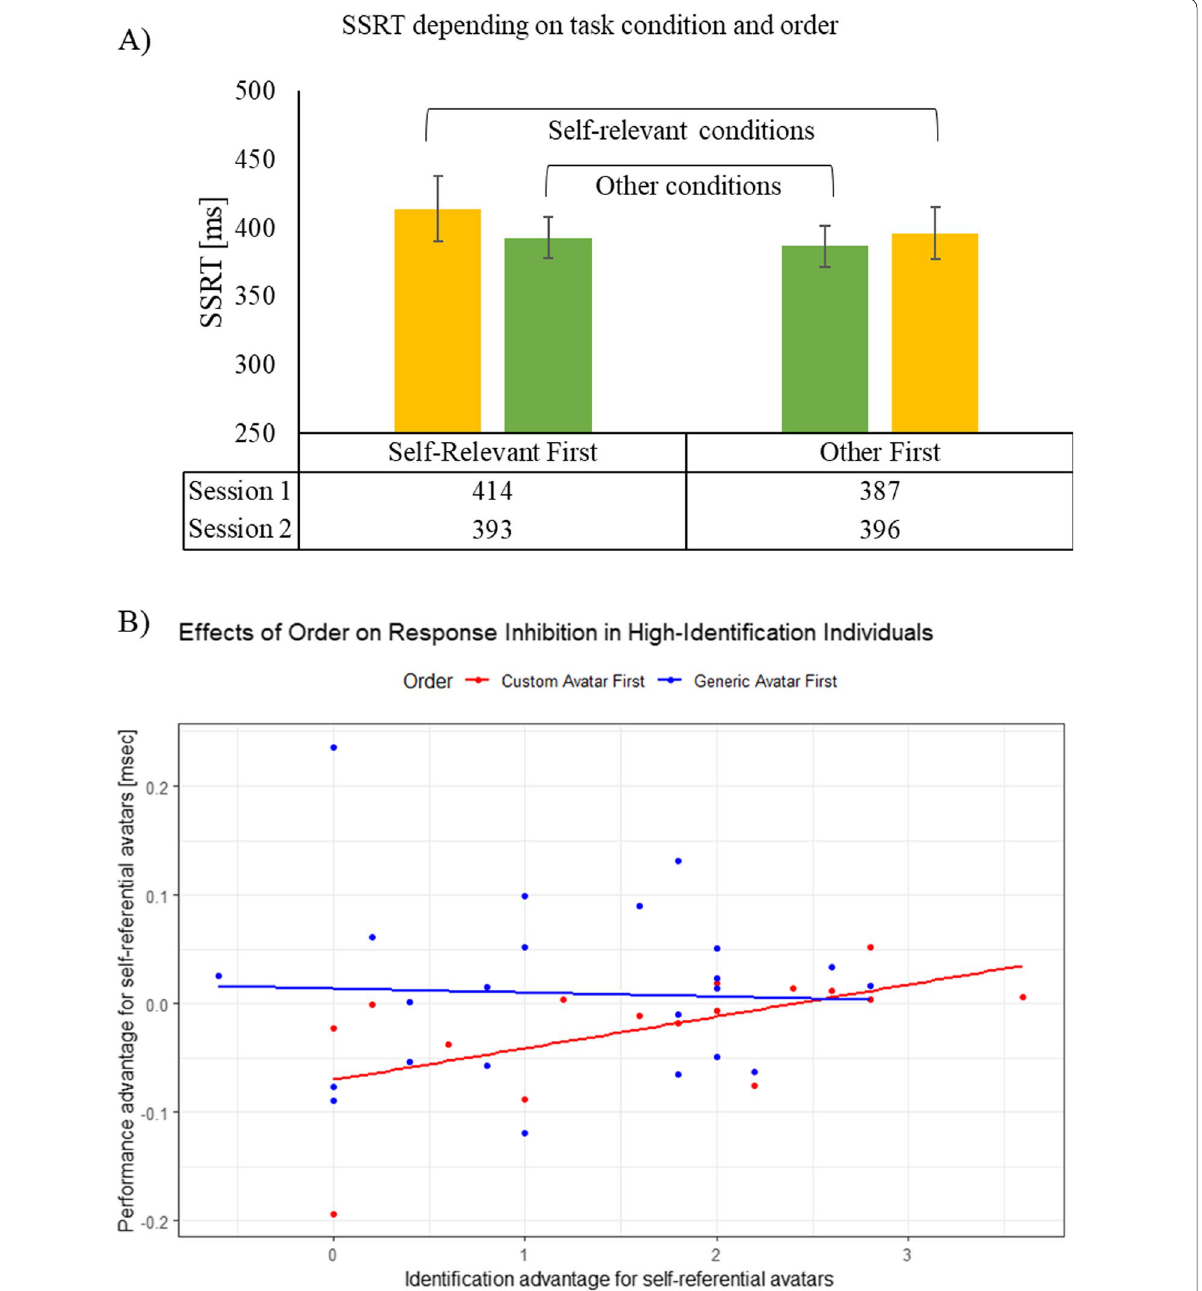
Fig. 4 Only participants that identified with the self-relevant avatar (i.e., for whom the manipulation was successful) were considered for this analysis. Note that in the stop-signal paradigm, a lower SSRT indicates a better performance. A lower SSRT means that the estimated inhibition process is faster. A Descriptive statistics for both conditions depending on the task order in which they were completed. If participants played the self-relevant condition first, their SSRT (i.e., the response inhibition speed) improved from session 1–2; vice versa for the other order condition. Error bars depict the standard error of the mean. B Increased identification through similarity with the avatar is predictive of a performance change; as measured by the difference in SSRT between the two conditions. The higher identification with the self-relevant avatar, when it was used first, leads to a larger difference between the task conditions, which correspond to session 1 and 2. This performance difference is predicted by the strength of the identification with the